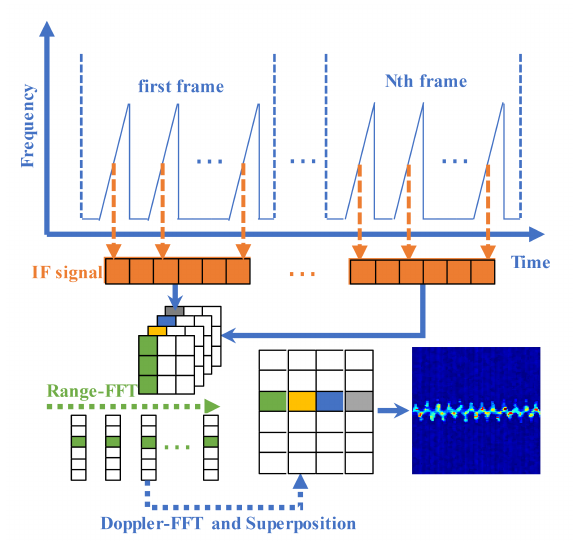
Figure 6. Range–Doppler feature overlay process.